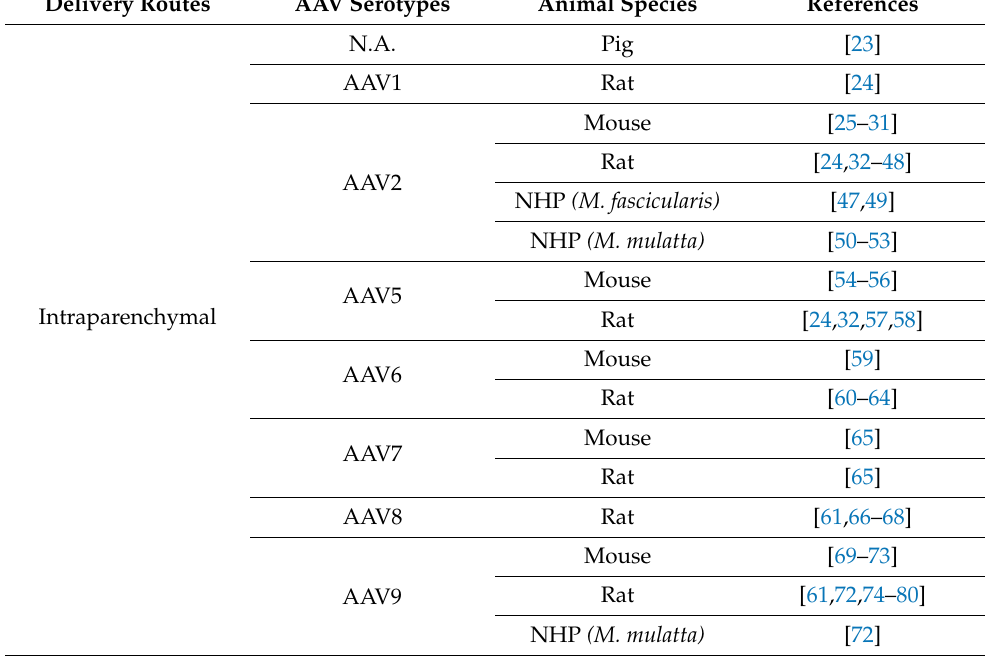
Table 1. Most commonly used AAV delivery routes in the context of Parkinson’s